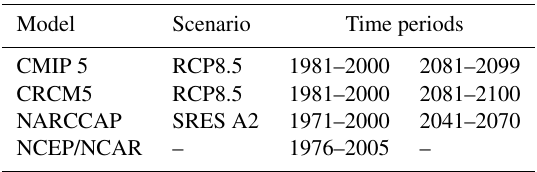
Table 1. Model products used in this study as well as time periods used for mean historical and future conditions. Abbreviations are defined in the